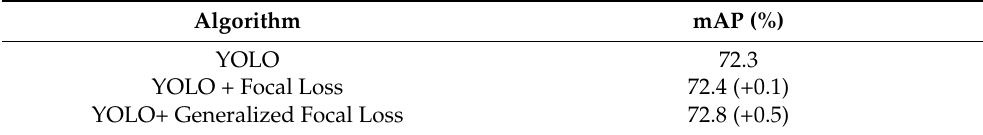
Table 2. Loss function optimization result.